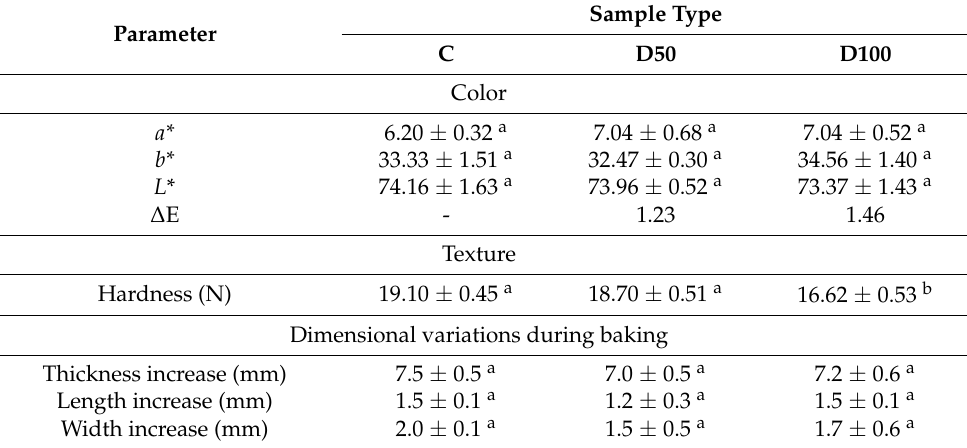
Table 7. Physical characteristics (color, texture, and dimensional variations during baking) of the experimental biscuits. C = Biscuits prepared with 100% sunflower oil; D50 = biscuits prepared with sunflower oil (50%) and durum wheat oil (50%); D100 = biscuits prepared with 100% durum wheat